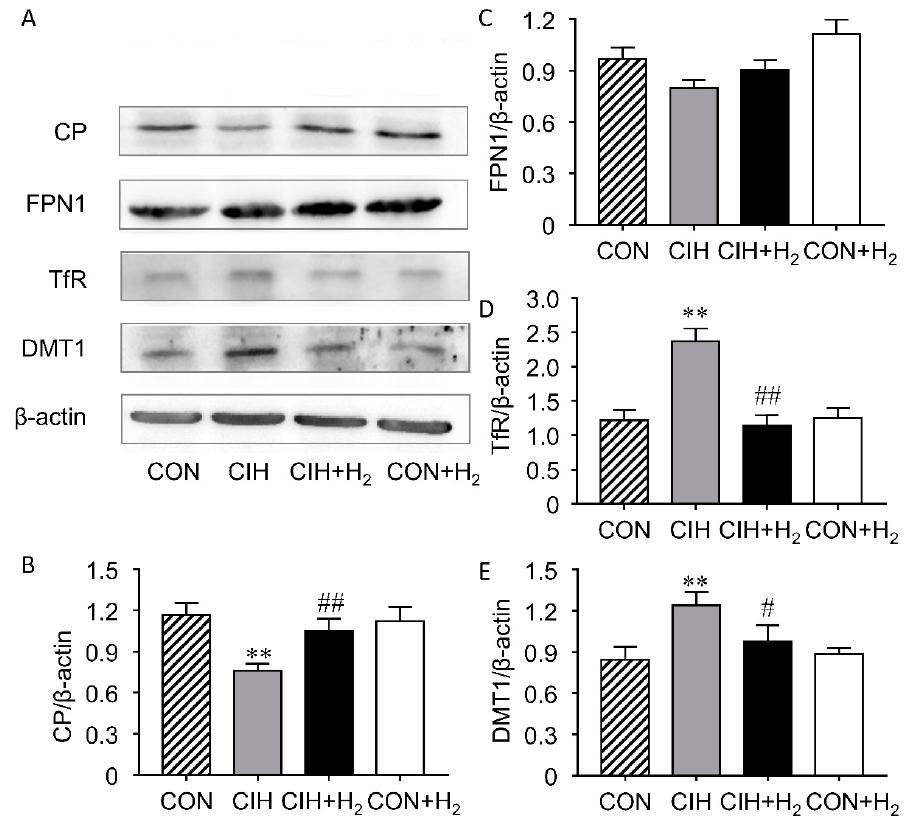
Figure 4. Effect of H 2 on renal iron transporting related proteins expression. H 2